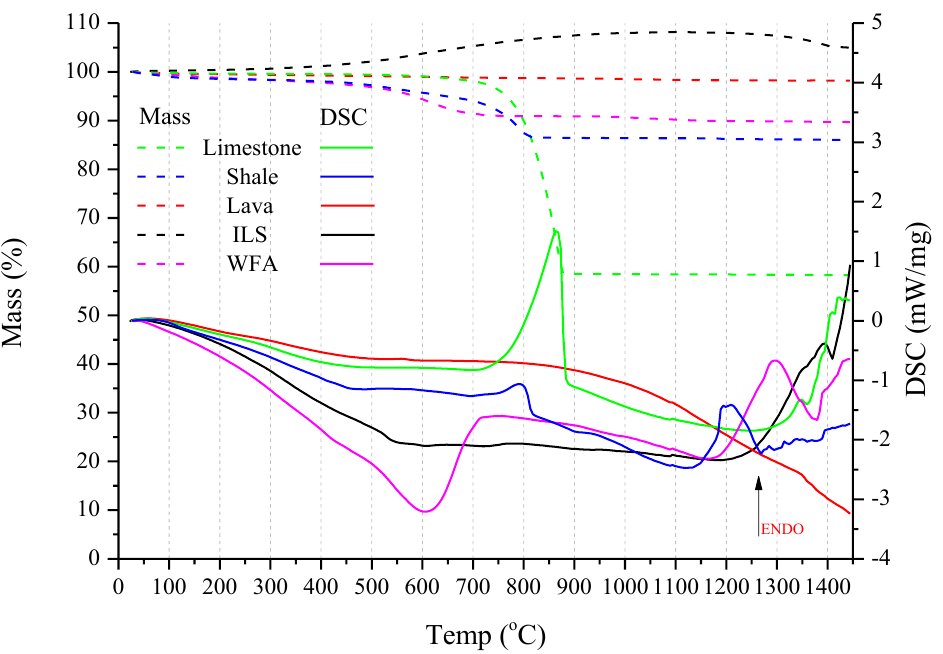
Figure 7. TGA/DSC curves of Limestone are presented in green, Shale in blue, Lava in red, ILS in black, and WFA in magenta. TG curves are with dashed lines and DSC with solid lines.